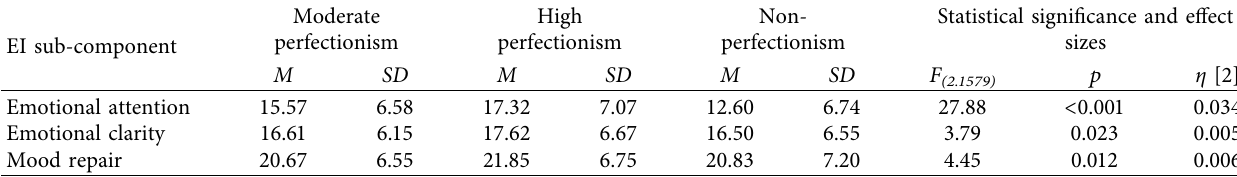
Table 3: Mean scores, standard deviations, and post-hoc contrasts obtained by the perfectionist profiles on EI sub-components. EI sub-component Emotional clarity